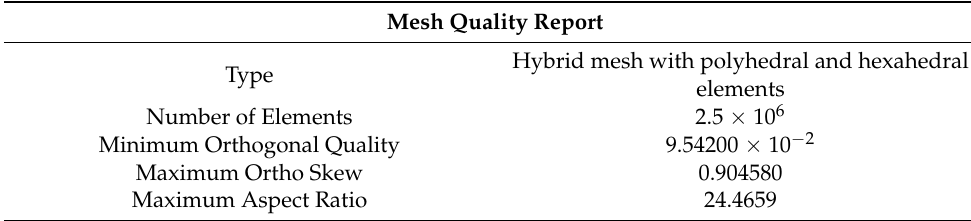
Table 3. Mesh quality